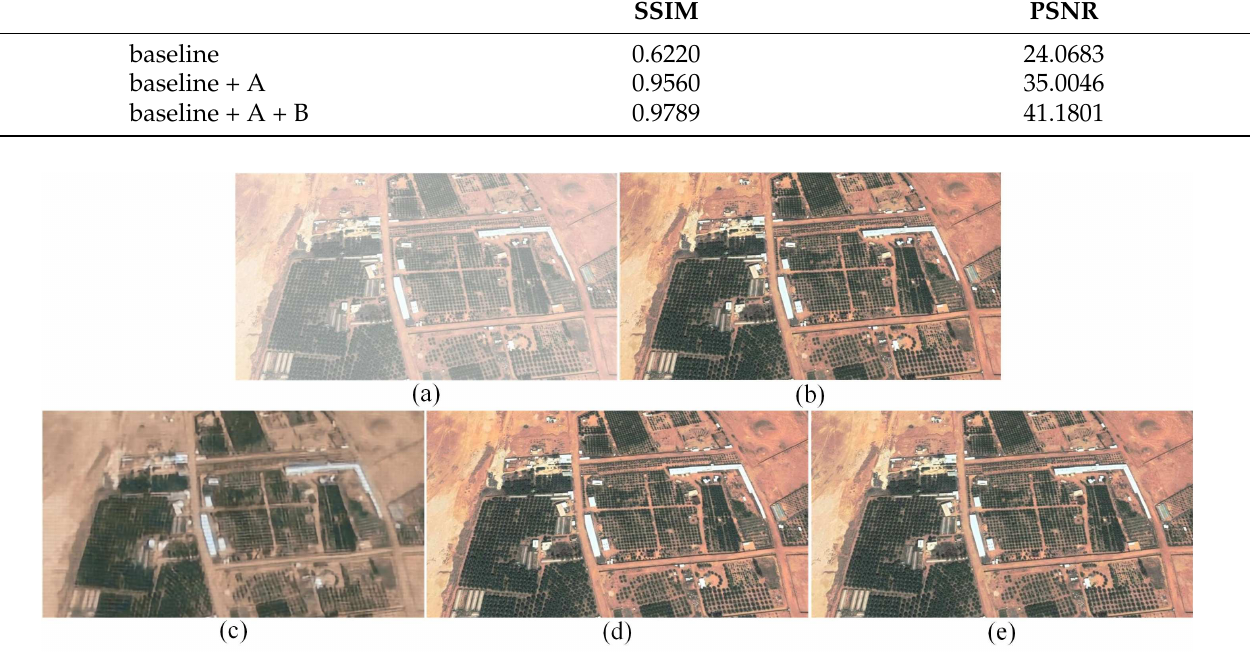
Table 4. Results of ablation study. Baseline is the encoding-decoding structure with residual OctConv. A represents SOS boosted module. B represents dual self-attention.